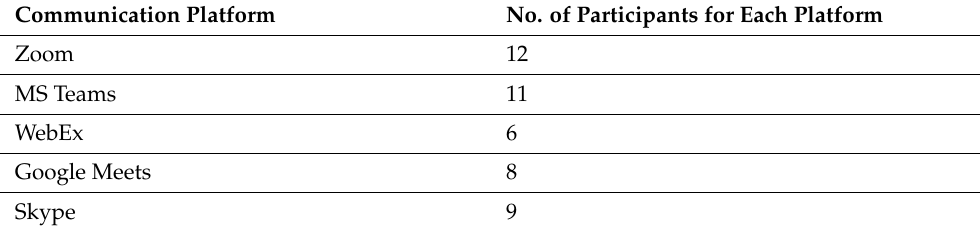
Table 2. Communication